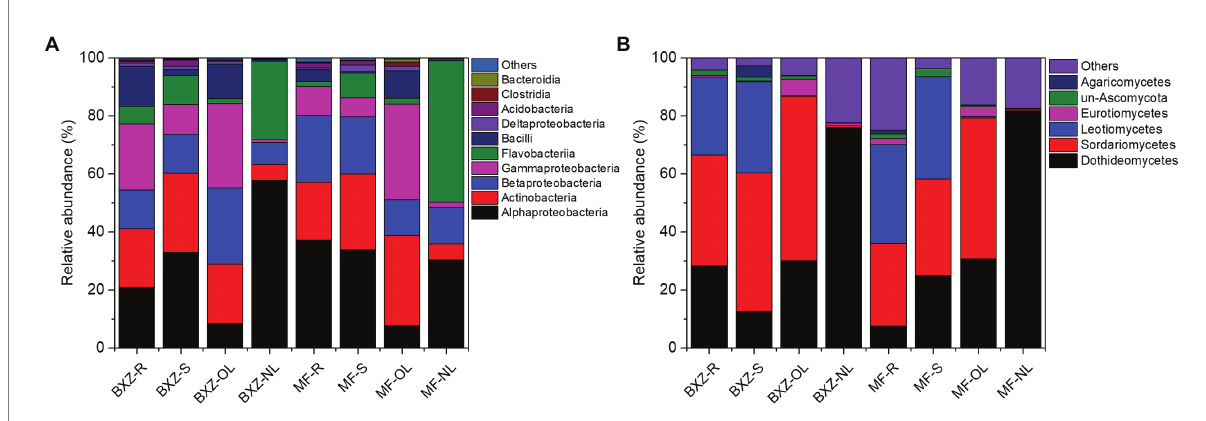
FIGURE 3 Taxonomic analysis of the endophytic bacterial (A) and fungal (B) communities at class level. BXZ_R, BXZ_S, BXZ_OL and BXZ_NL represented root, stem, old leave and new leave samples of BXZ cultivar., while MF_R, MF_S, MF_OL and MF_NL represented root, stem, old leave and new leave samples for MF